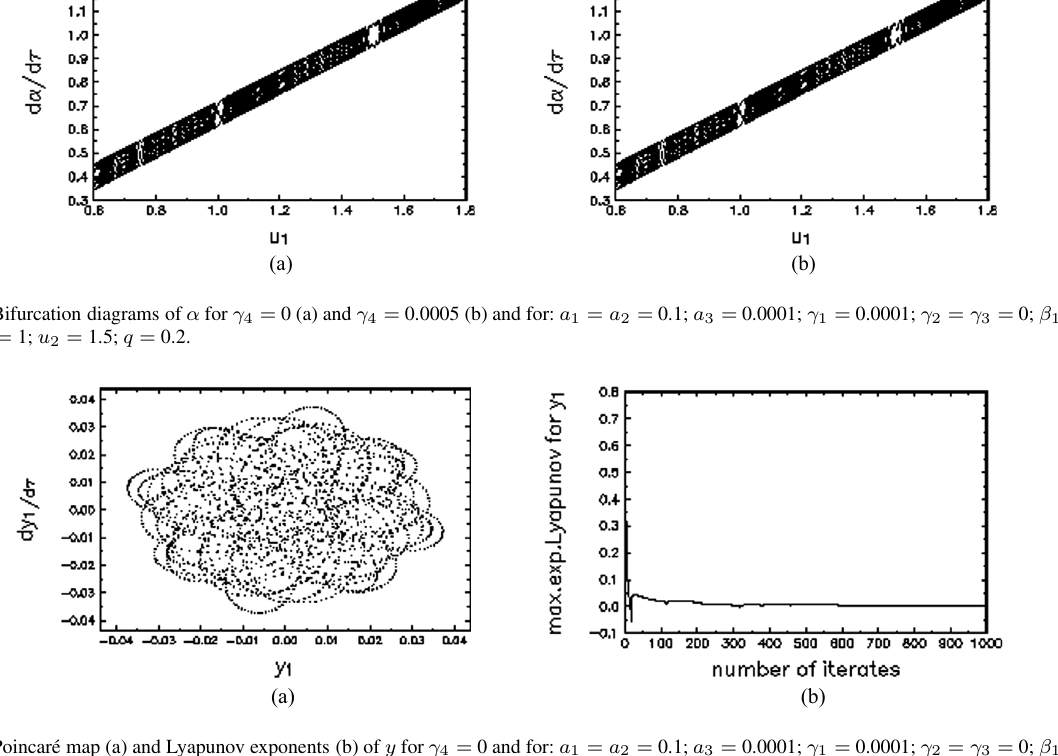
Fig. 9. Poincaré map (a) and Lyapunov exponents (b) of y for γ 4 = 0 and for: a 1 = a 2 = 0.1; a 3 = 0.0001; γ 1 = 0.0001; γ 2 = γ 3 = 0; β 1 = 0.65; c = 1; u 1 = u 2 = 1.5; q = 0.2.